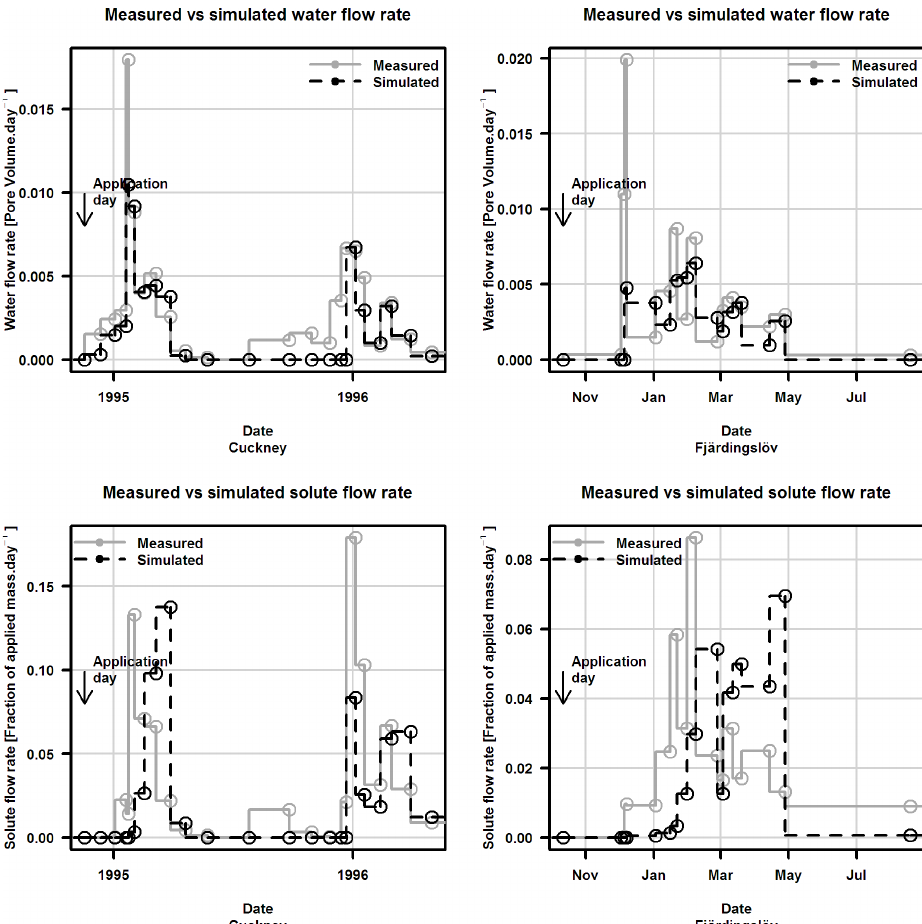
Fig. 3. Examples of measured versus simulated water and solute flows, for one soil that is “rather well” simulated (Cuckney) and one that is “rather poorly” simulated (Fj¨ardingsl¨ov). Solid lines are measured values and dashed lines are simulated